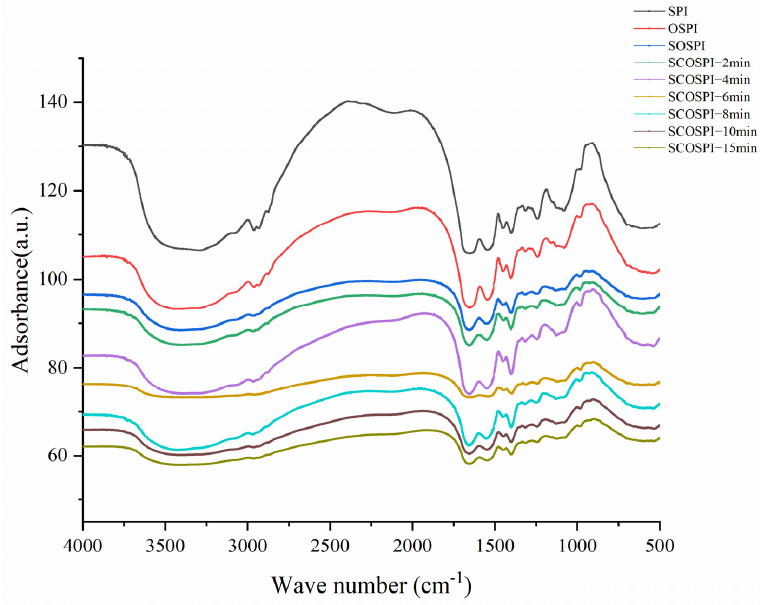
Figure 3. FTIR spectra of natural, oxidized soybean protein, and cavitation jet treated on soluble soybean protein oxidized accumulates at several times (2, 4, 6, 8, 10, and 15 min). Table 2. Secondary structure content of natural, oxidized soybean protein, and cavitation jet treated on soluble soybean protein oxidized accumulates at several times (2, 4, 6, 8, 10, and 15 min).